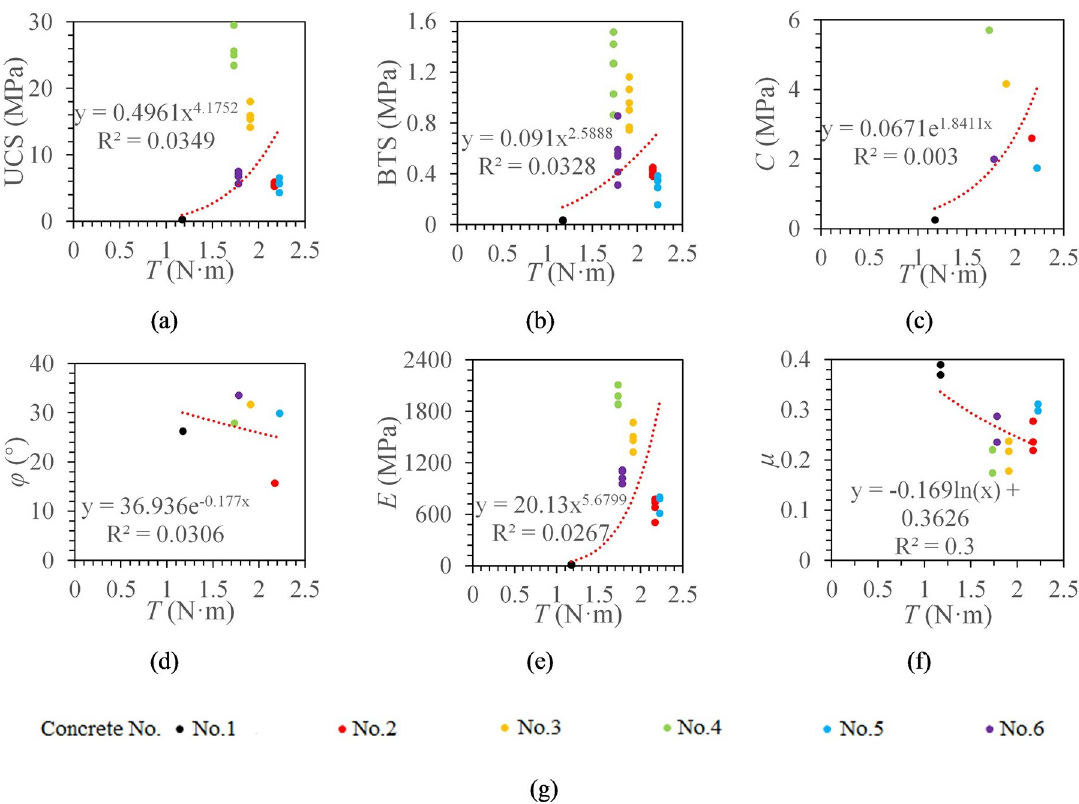
Fig 7. The relationship between torque and the concrete mechanical properties. T indicates torque. (a) The relationship between T and UCS. (b) The relationship between T and BTS. (c) The relationship between T and C . (d) The relationship between T and φ . (e) The relationship between T and E . (f) The relationship between T and μ . (g)